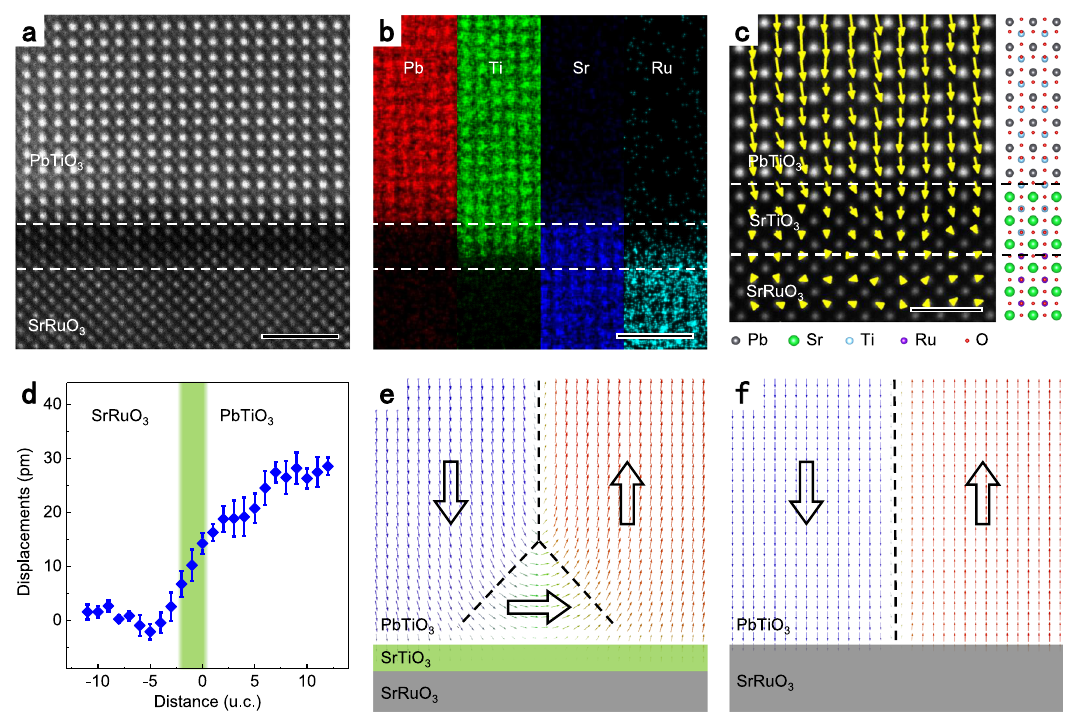
d The quantitative measurement of polar displacements as a function of the dis- tance away from the PbTiO 3 /SrRuO 3 interface. The colored region denotes the location of the diffused SrTiO 3 layer. Polarization con fi gurations at interfaces with ( e ) and without ( f ) a SrTiO 3 layer from phase- fi eld simulations. Arrows indicate directions of